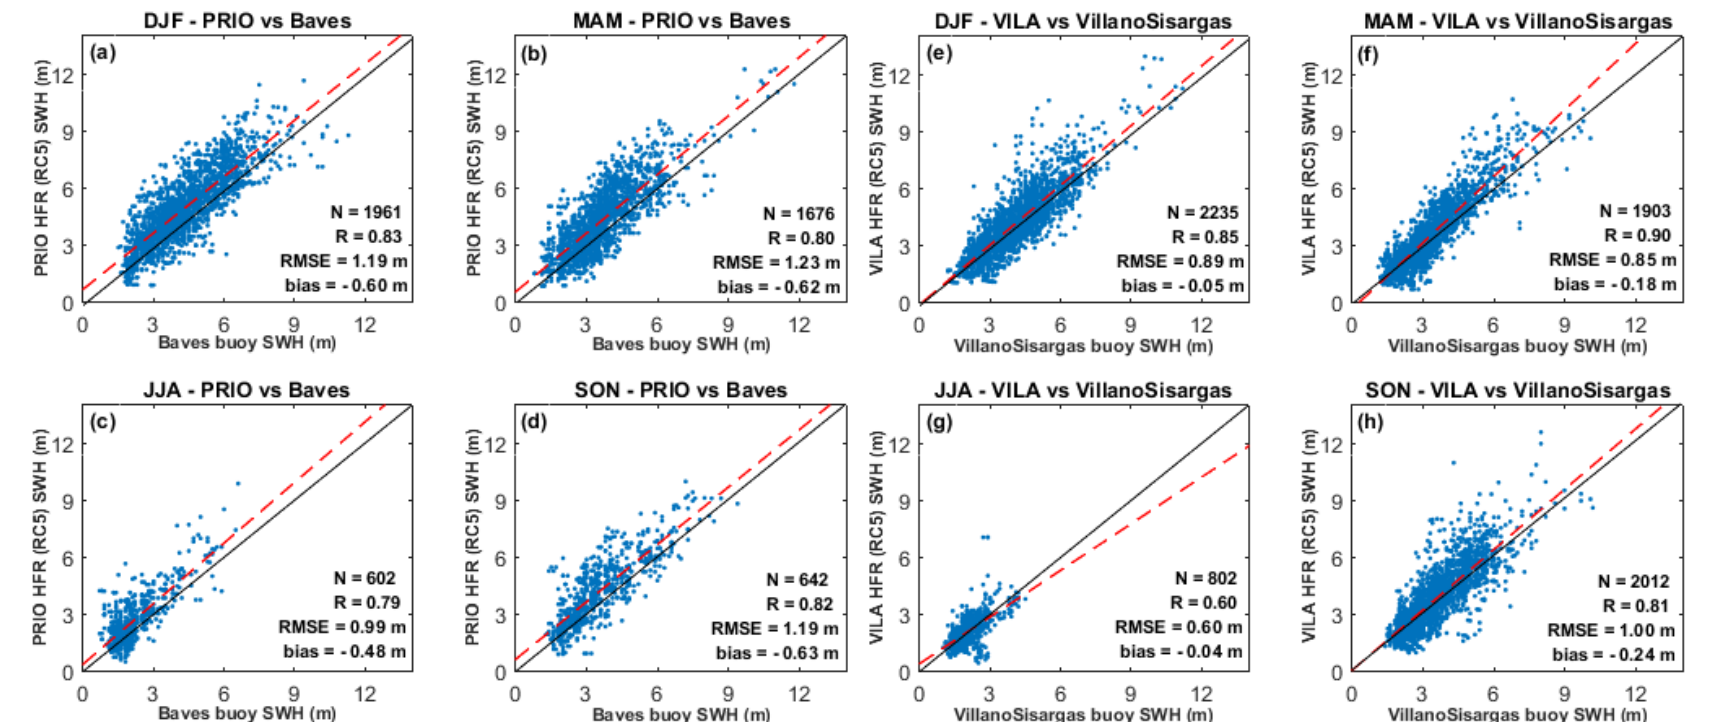
Figure A1. Seasonal comparisons between HFR SWH and buoy (scatter plots). Seasons: DJF—December, January, February; MAM—March, April, May; JJA—June, July, August, and SON—September, October, November. Statistics metrics are gathered on the right bottom side. N represents the number of coincident hourly observations, and the red dashed lines are the best linear fit of the scatter plots. ( a ) DJF–PRIO vs. Baves; ( b ) MAM–PRIO vs. Baves; ( c ) JJA–PRIO vs. Baves; ( d ) SON–PRIO vs. Baves; ( e ) DJF–VILA vs. Villano-Sisargas; ( f ) MAM–VILA vs. Villano-Sisargas; ( g ) JJA–VILA vs. Villano-Sisargas, and ( h ) SON–VILA vs. Villano-Sisargas.